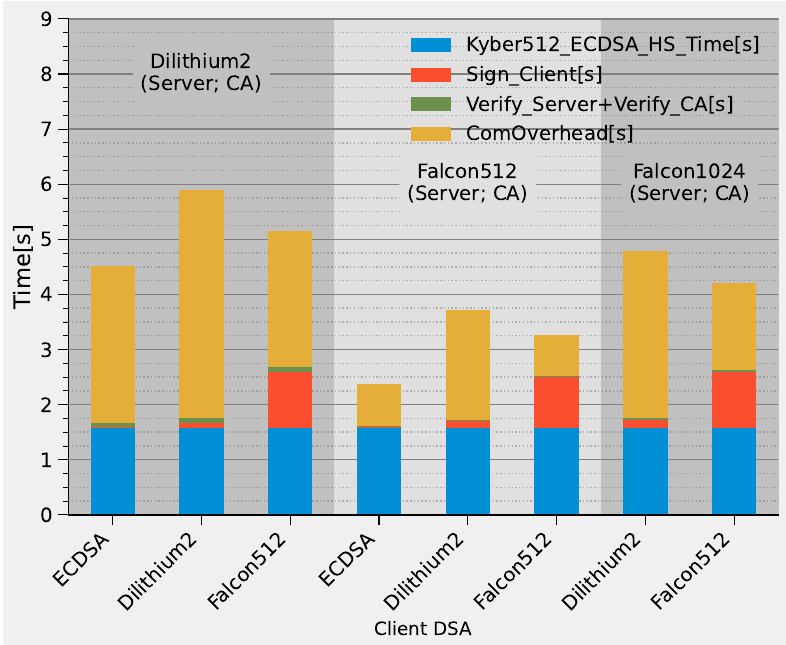
Figure 10. TLS 1.2 handshake latency for different PKIs with post-quantum DSAs.